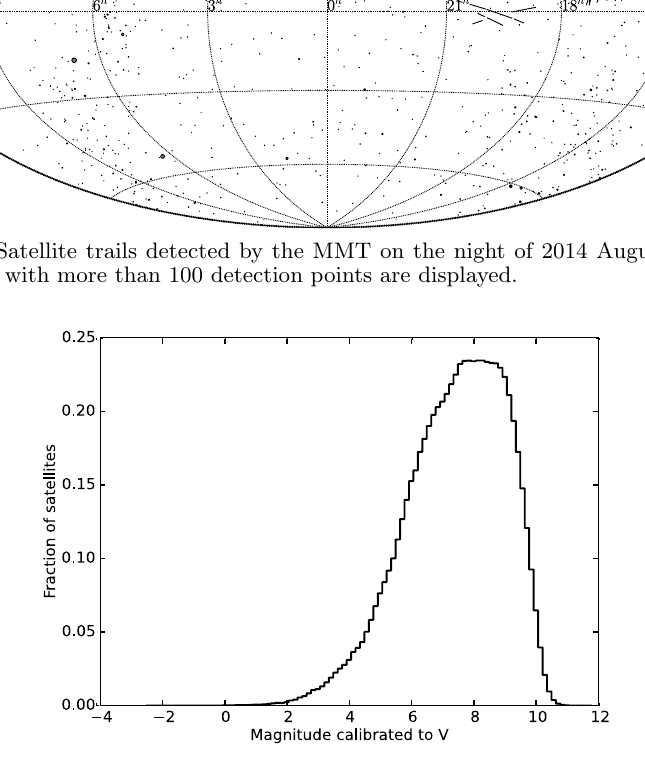
Fig. 8. Overall distribution of mean magnitudes of satellite tracks detected over seven months of MMT